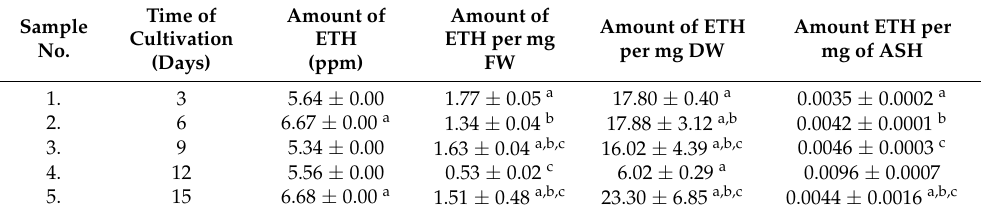
Table 1. Effectivity of ETH production in relation to the FW, DW ASH of initial tissue according to the length of passage time for 80 mL of ½ MS medium supplemented with 9.05 µM 2,4-D + 0.88 µM BAP.